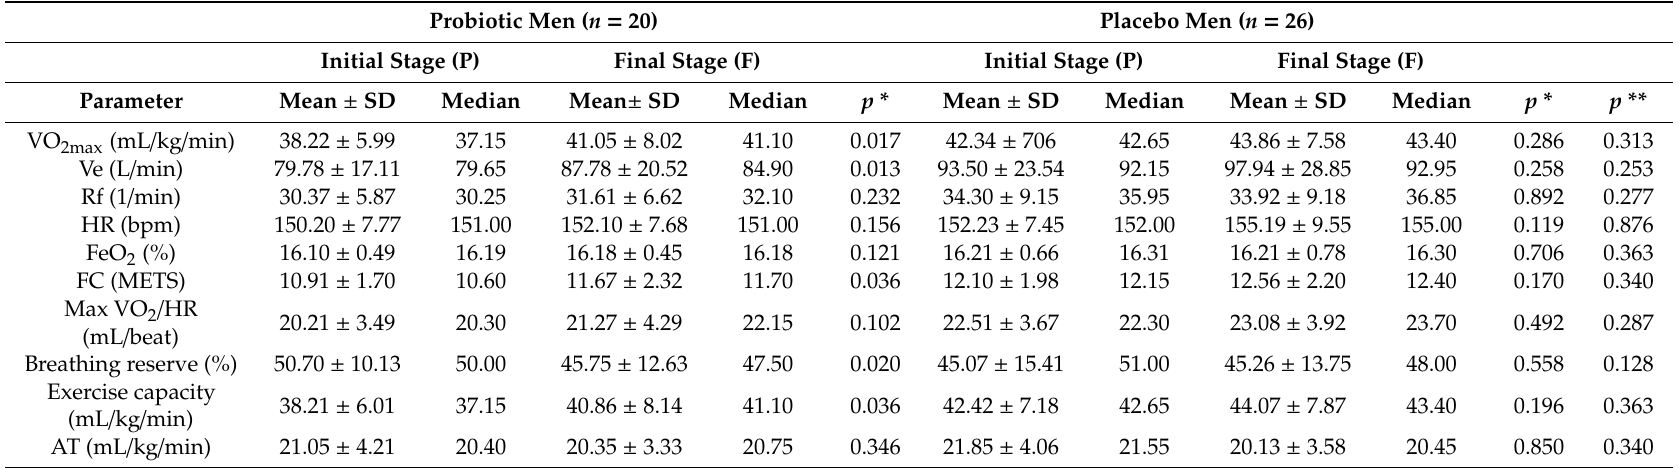
Table 4. Analysis of selected parameters of cardiorespiratory fitness of men from the probiotic and placebo groups at the initial and final stages of intervention.